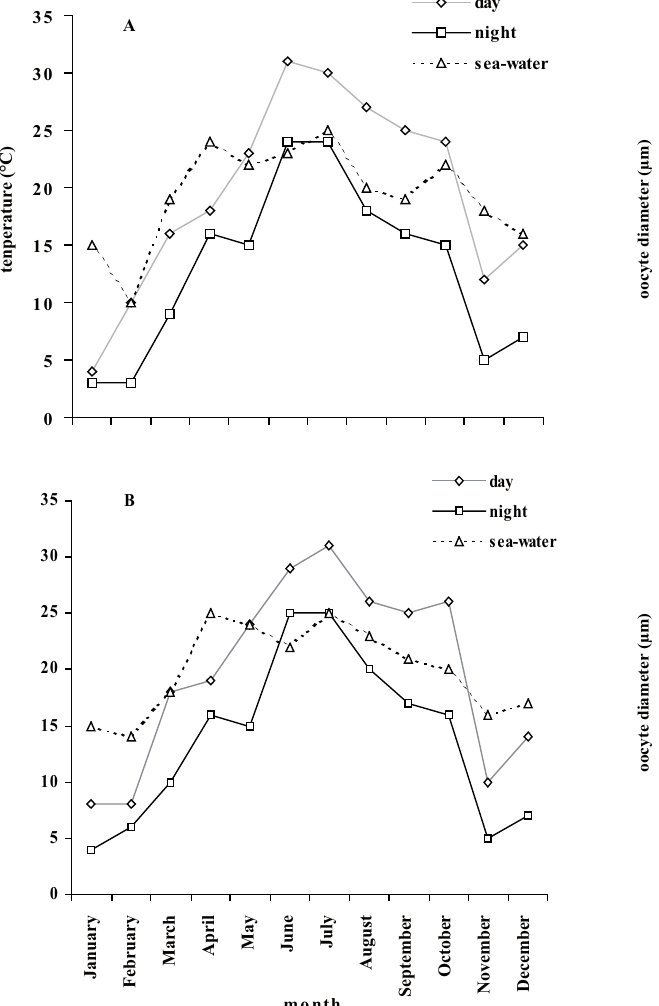
Fig . 3. – Monthly sea-water and air temperature during low tide and air temperature at night. A: Pointe-Pescade, B: Figuier.